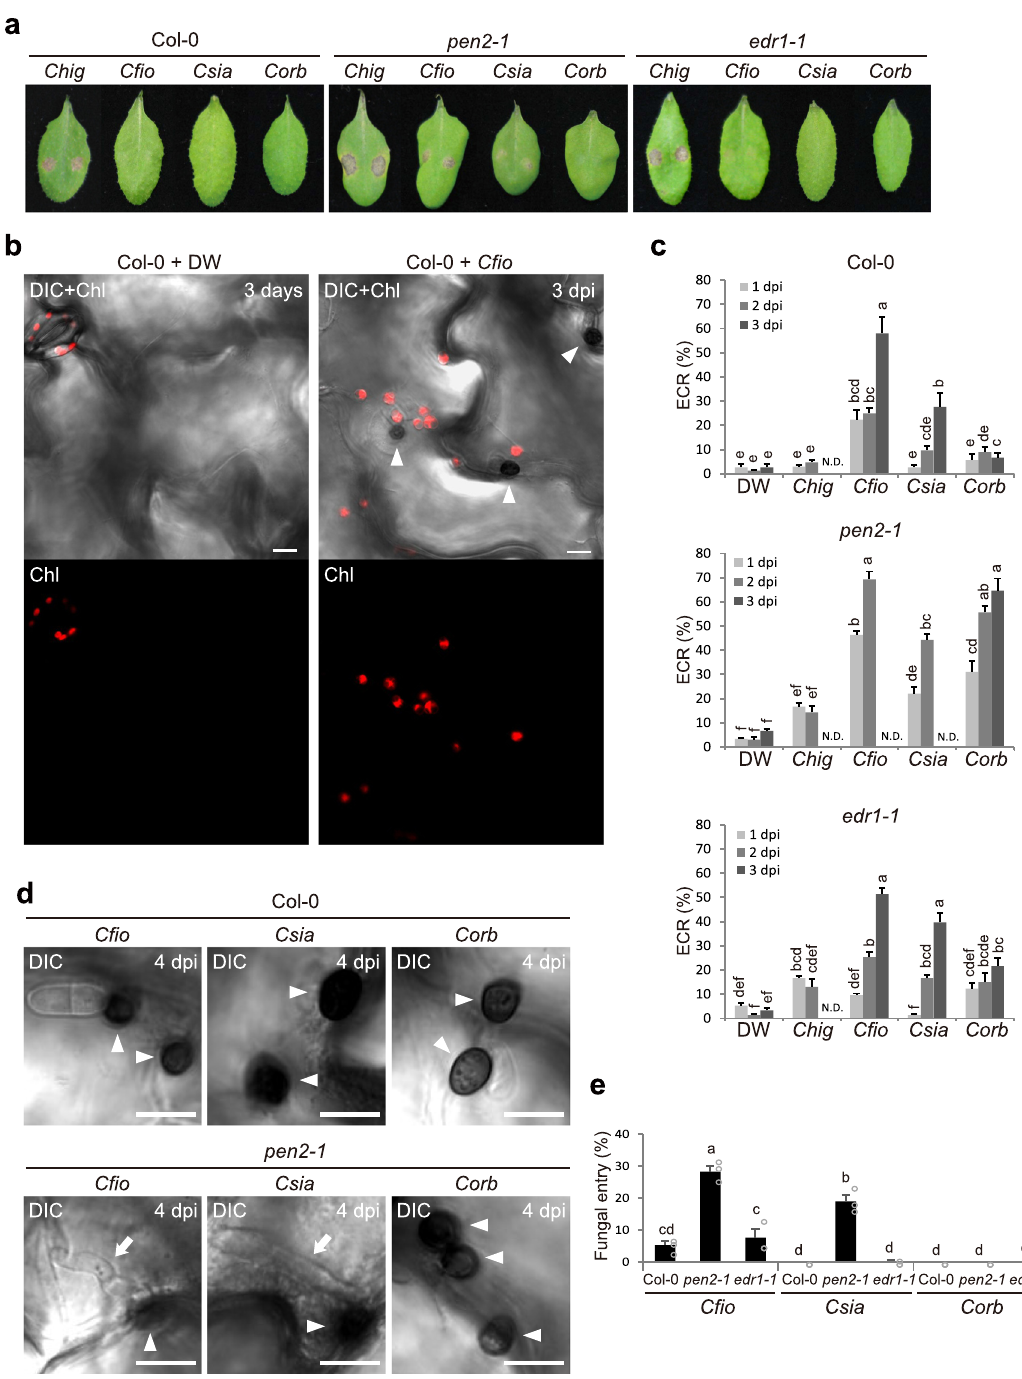
Fig. 1 The ECR occurs at the lower layer of PEN2-related immunity and is critical for NHR against Colletotrichum fungi. a Pathogenicity of Colletotrichum fungi on Arabidopsis mutants. A conidial suspension of adapted Chig and nonadapted C fi o , Csia , and Corb was inoculated onto leaves of wild-type Arabidopsis (Col-0), pen2-1 , and edr1-1 and incubated for 7 days. b ECR after C fi o inoculation. The epidermal surface of the C fi o -inoculated cotyledon of Col-0 was investigated at 3 days post-inoculation (dpi). The chloroplasts were visualized based on chlorophyll auto fl uorescence. The DIC images were captured by confocal microscopy. DW was used as a control. c The ratio of epidermal cells with surface chloroplasts was investigated at 1, 2, and 3 dpi. A total of 100 cells in contact with the melanized appressorium were observed. N.D.: not determined due to damages of epidermal cell by fungal invasion. d , e Fungal invasion of Arabidopsis epidermis. C fi o , Csia , and Corb were inoculated onto cotyledons of the indicated Arabidopsis . The entry ratio was quanti fi ed at 4 dpi. A total of 100 melanized appressoria were investigated. The arrowheads and arrows indicate melanized appressoria and invasive hyphae, respectively. Scale bar, 10 µ m. The means and SE were calculated from three independent plants. Means not sharing the same letter are signi fi cantly different ( P < 0.05, two-way ANOVA with Tukey ’ s HSD